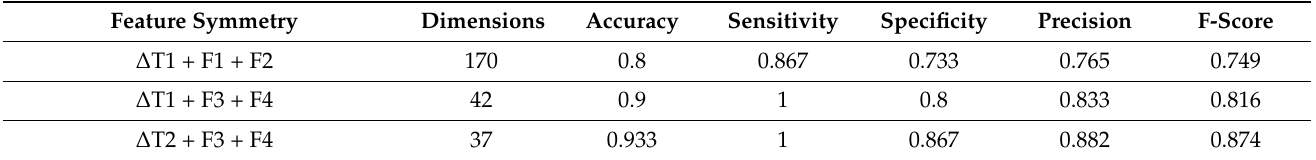
Table 10. Diagnostic performance of facial paralysis using a combination of temperature and texture feature symmetry. Feature Symmetry